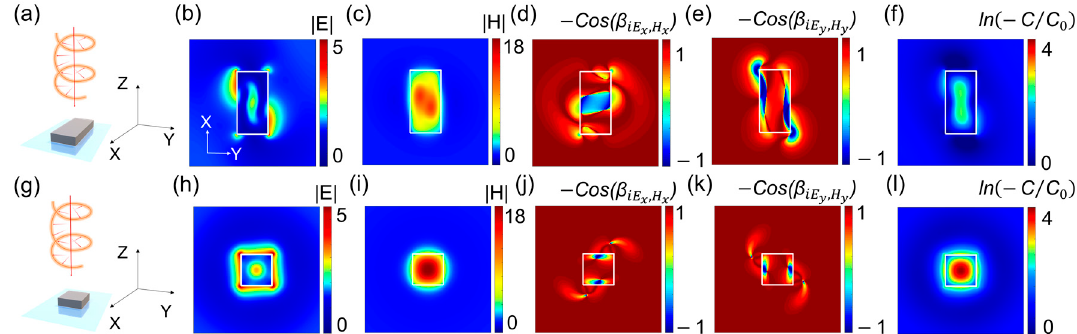
Figure 2. The enhanced optical chirality in two types of Si structures at the wavelength of 475 nm. The first type is designed as a nanorod with a length of 250 nm ( a – f ), and the second type is designed as a squared nanoblock with a length of 125 nm ( g – l ). ( a – c ) The schematic of the nanorod ( a ), and the images of the electric field ( b ) and the magnetic field ( c ) monitored from the cross-sectional x-y plane in ( a ), i.e., top view. ( d – f ) The spatial distributions of the relative phase between the electric and magnetic fields for x-directed ( d ) and y-directed polarizations ( e ) and the C enhancement ( f ). ( g – i ) The schematic of the squared nanoblock ( g ) and the images of the electric and magnetic fields in the squared nanoblock for the same conditions of ( b , c ). ( j – l ) The spatial distributions of the relative phase of the electric and magnetic fields ( j , k ) and C enhancement ( l ) in the squared nanoblock for the same conditions of ( d – f ).